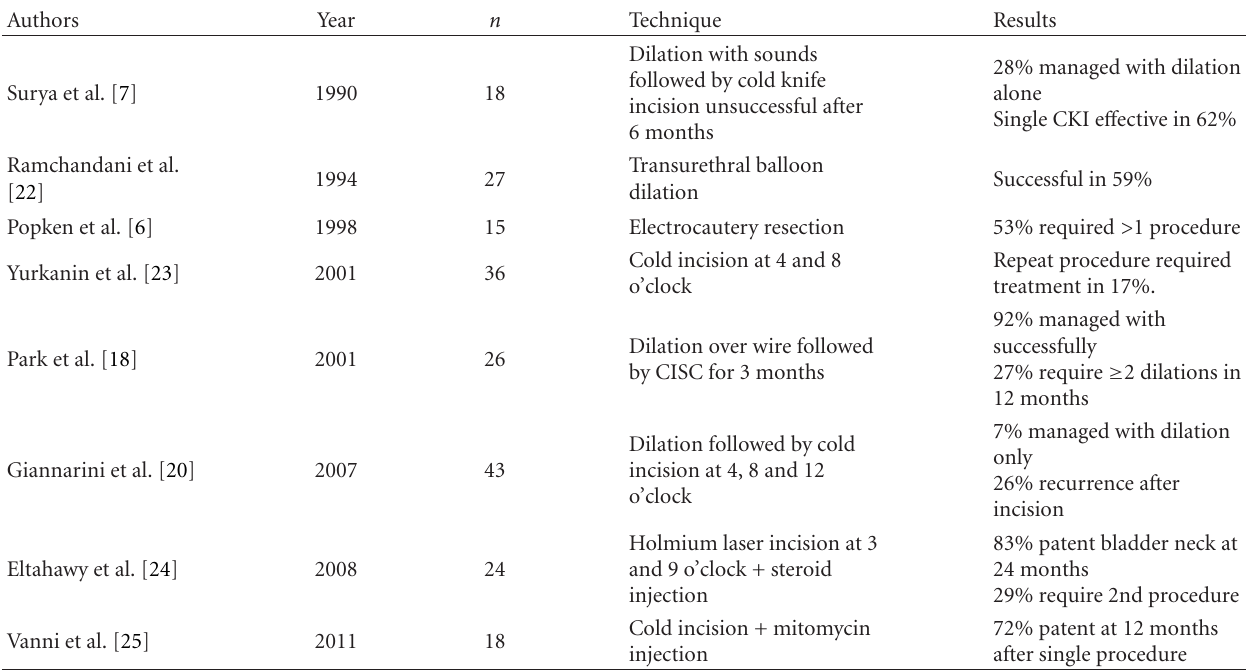
Table 1: Endoscopic management of postprostatectomy bladder neck